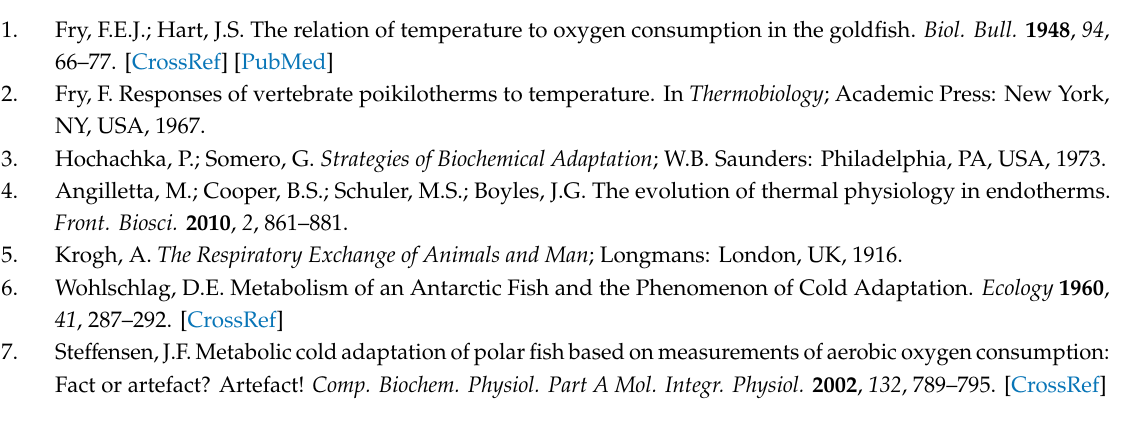
Figure S1: SMR of spotted seatrout sampled from SC at two di ff erent time periods: SC 1 ( n = 5, sampled Nov 2017) and SC 2 ( n = 6, sampled Mar 2018). Table S1: Details on the spotted seatrout specimens used in this study. Table S2: Summary of mass-specific SMR and MMR for both SC and VA spotted seatrout